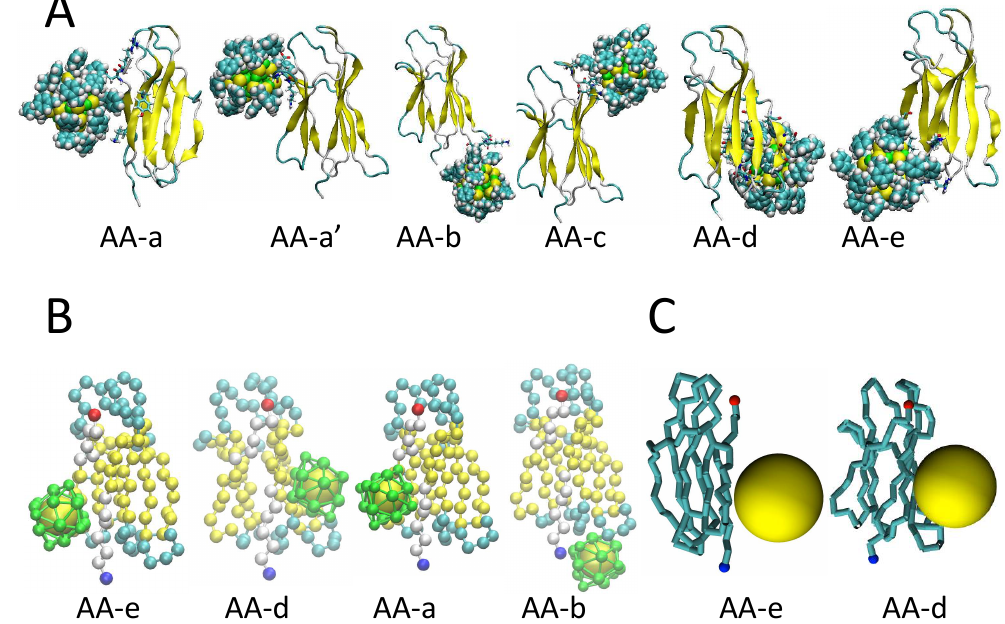
Figure 1. A pictorial description of binding modes. Most populated encounter complexes of β 2 µ ( β 2-microglobulin) on gold nanoparticle obtained by AA atomistic model ( A ) (reprinted with permission from Brancolini G., Toroz D., Corni S. (2014) Nanoscale , 6, 7903-7911) [7], with the CG (coarse-grained) model ( B ), and with the MS (mesoscale) model ( C ), respectively. The structures of representative complexes are ordered by decreasing cluster population. The protein backbone is shown in cartoon representation for the atomistic model and van der Waals representation for the CG and mesoscale models. In ( B ) and ( C ), each pose is labeled with the letter of the most similar AA atomistic pose.